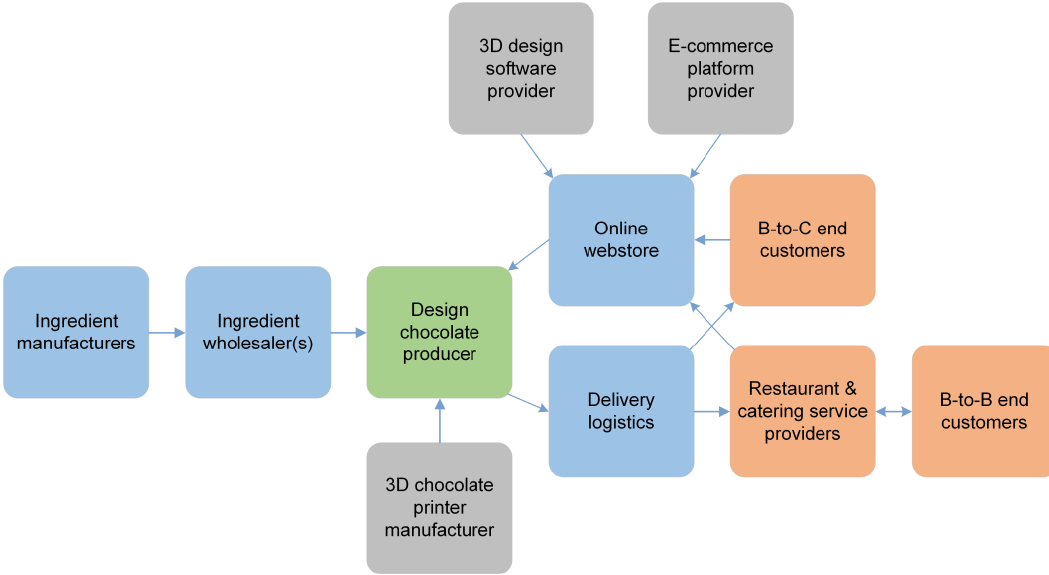
Figure 8. Value chain of the business model—Customized design